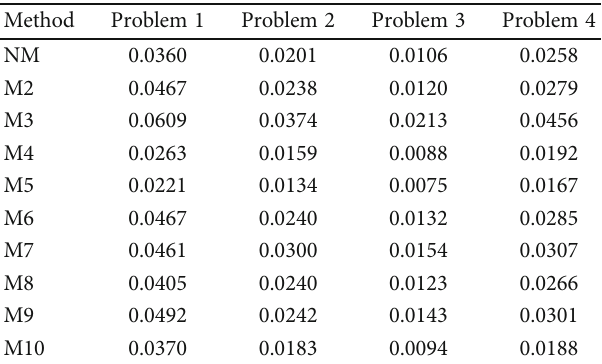
Table 4: Values of CR2 for methods 1-10 to solve all test problems, and n = 500